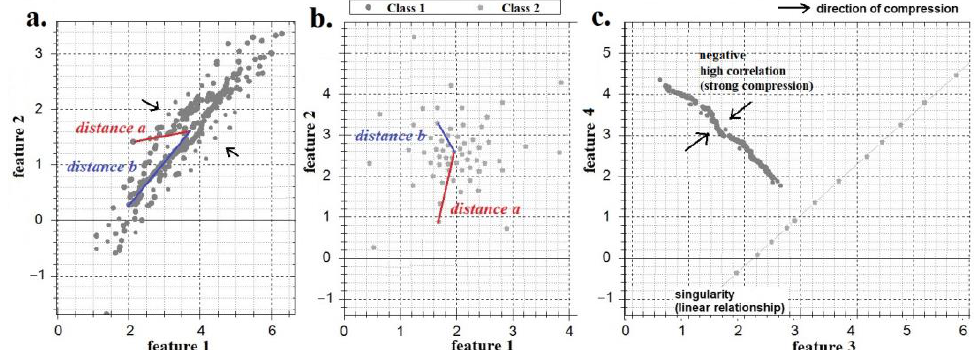
Figure 3. The direction of space compression of two features ( a ) with a positive significant correlation between features (the distance “ a ” is greater than the distance “ b ” since the feature space is not “ flat ” but curved due to the correlation); ( b ) with independent features (distance “ a ” is greater than “ b ” ); ( c ) with different correlations.